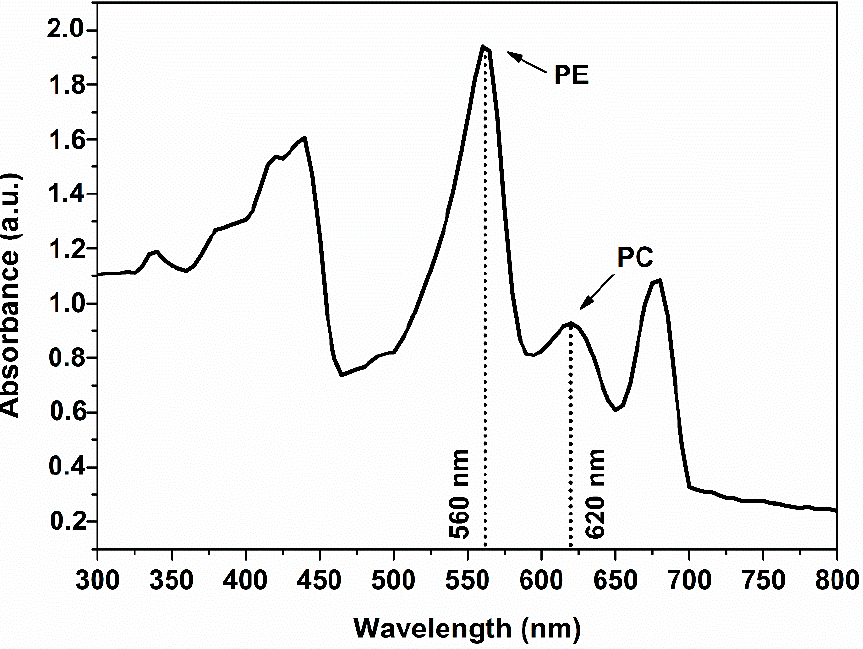
Figure 2. UV-vis spectra of cyanobacterium extract, where the absorption bands corresponding toPE and PC are indicated.